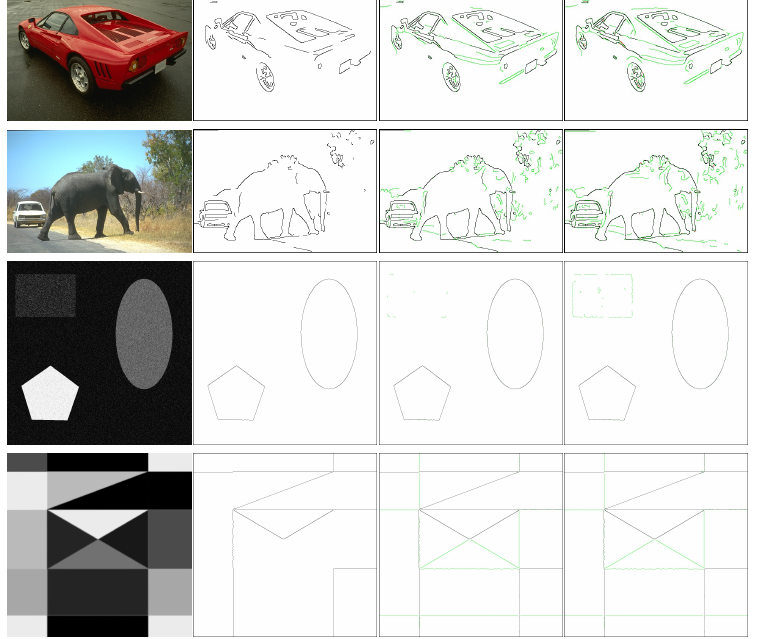
Figure 1. Example of edge map results using Canny algorithm configured with the same parameters. Columns are: Original image; Canny using 3 × 3 kernel; Canny using dilated 5 × 5 kernel; Canny using dilated 7 × 7